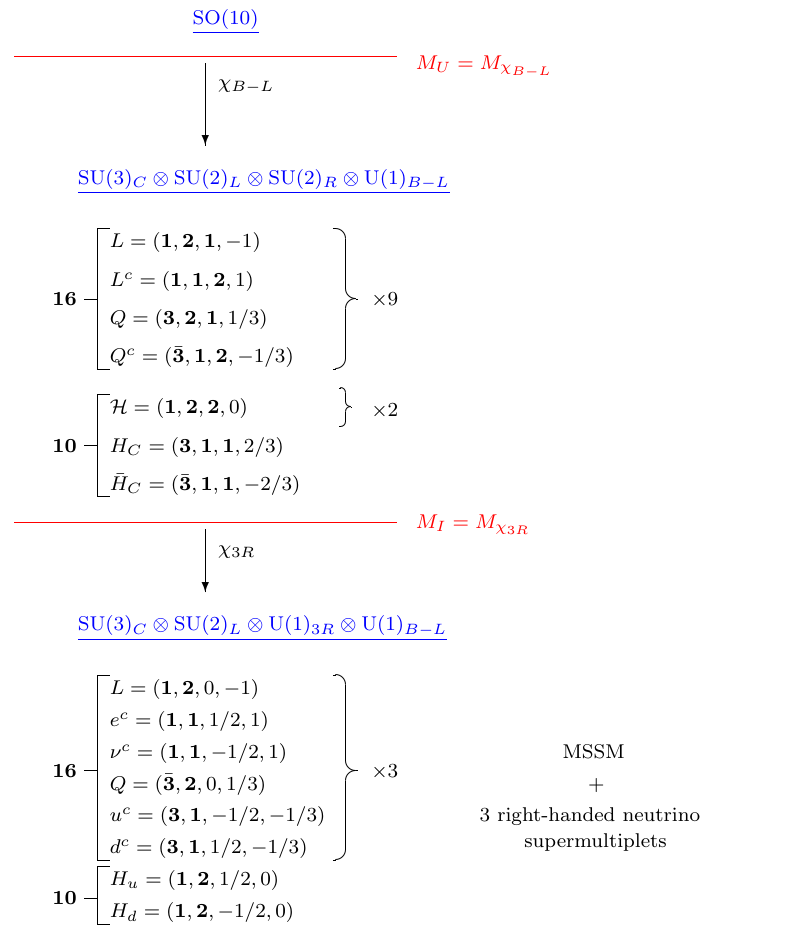
Figure 1. The particle spectra in the scaling regimes of the sequential Wilson line breaking pattern of SO(10) in which M (cid:31) = M U > M (cid:31) = M I . B (cid:0) L 3 R